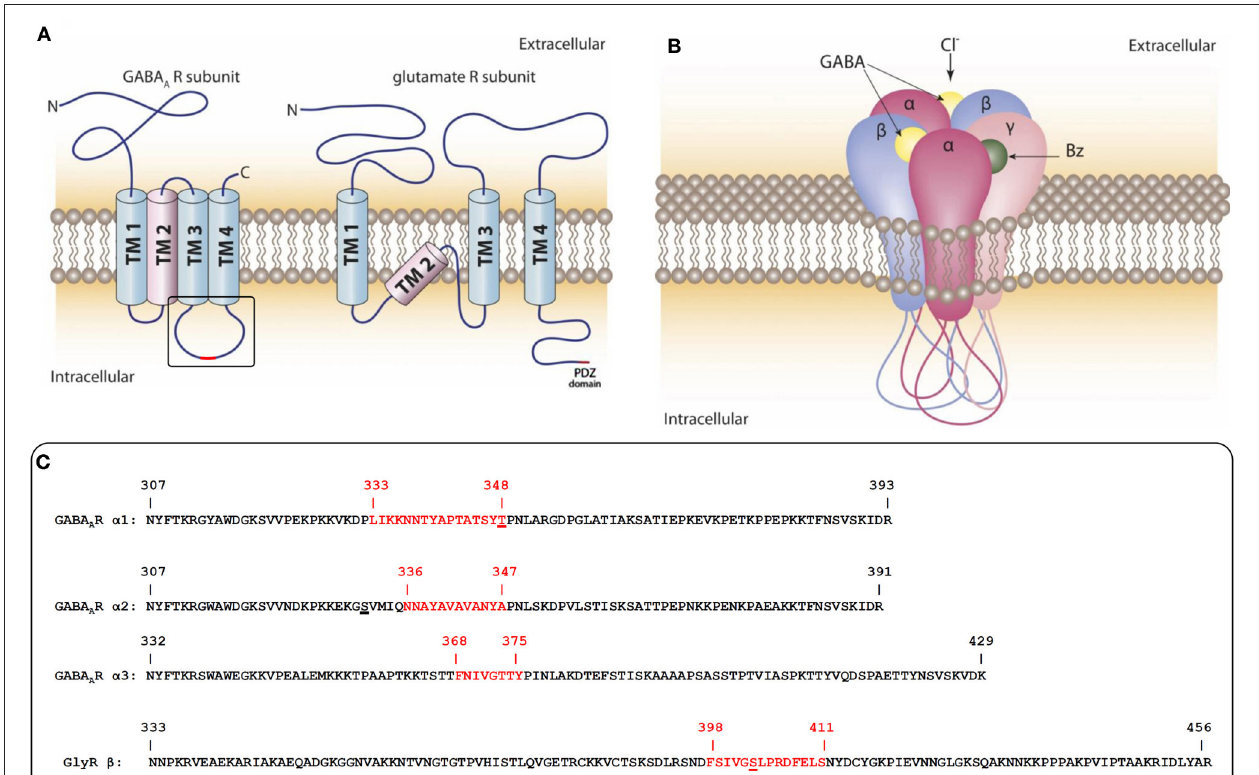
drugs. The intracellular loops of all five subunits are substrates for post-translational modifications that dynamically regulate interactions with other proteins. Some protein interactions might require more than one cytoplasmic loop. (C) Sequences of intracellular loops of GABA A R α 1, α 2, and α 3 subunits and the GlyR β subunit from rat. The sequences identified as gephyrin interaction sites are highlighted in red. Identified phosphorylation sites within or near the gephyrin interaction sites are